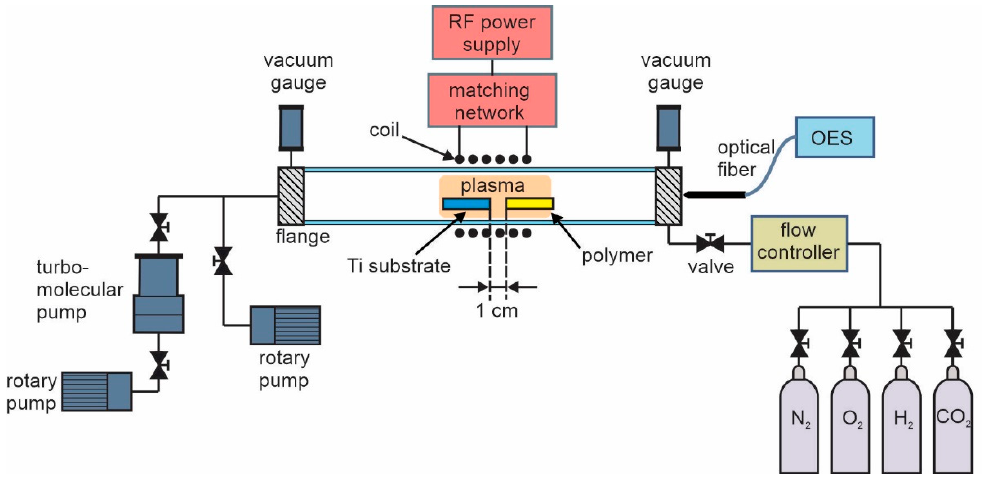
Figure 1. Experimental